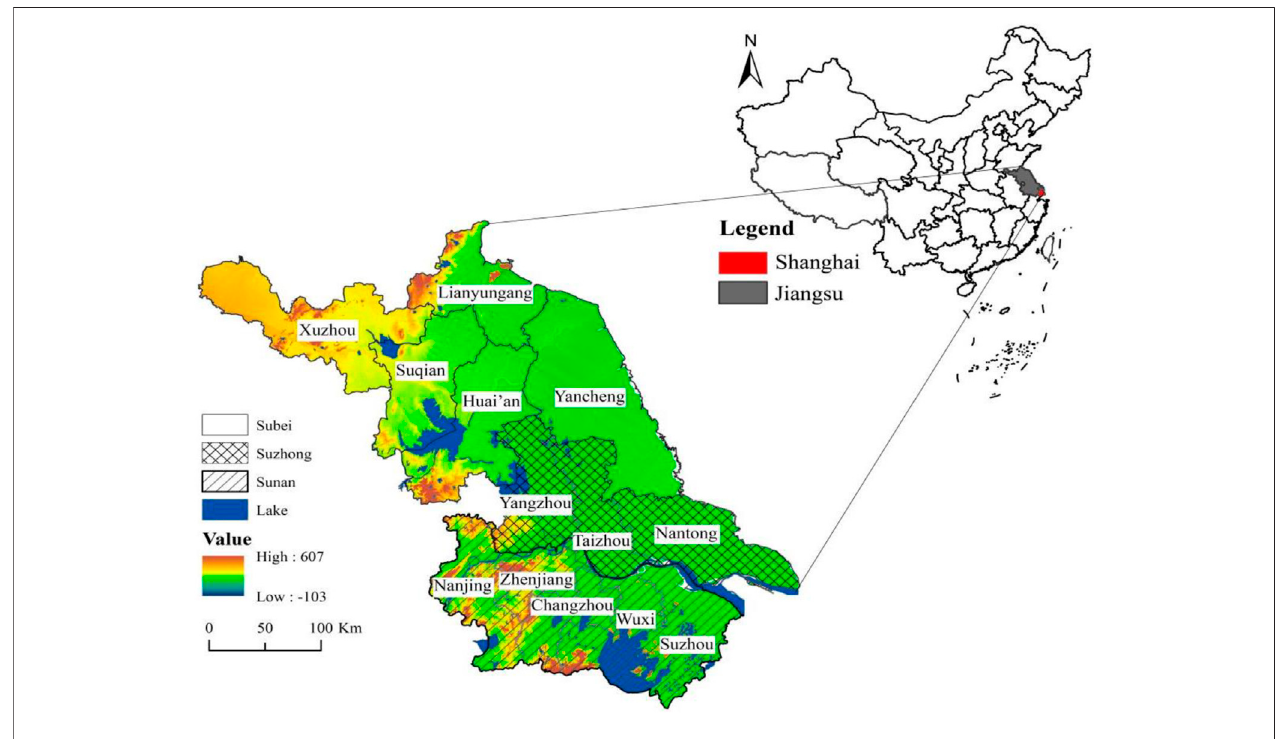
FIGURE 1 | The study area.